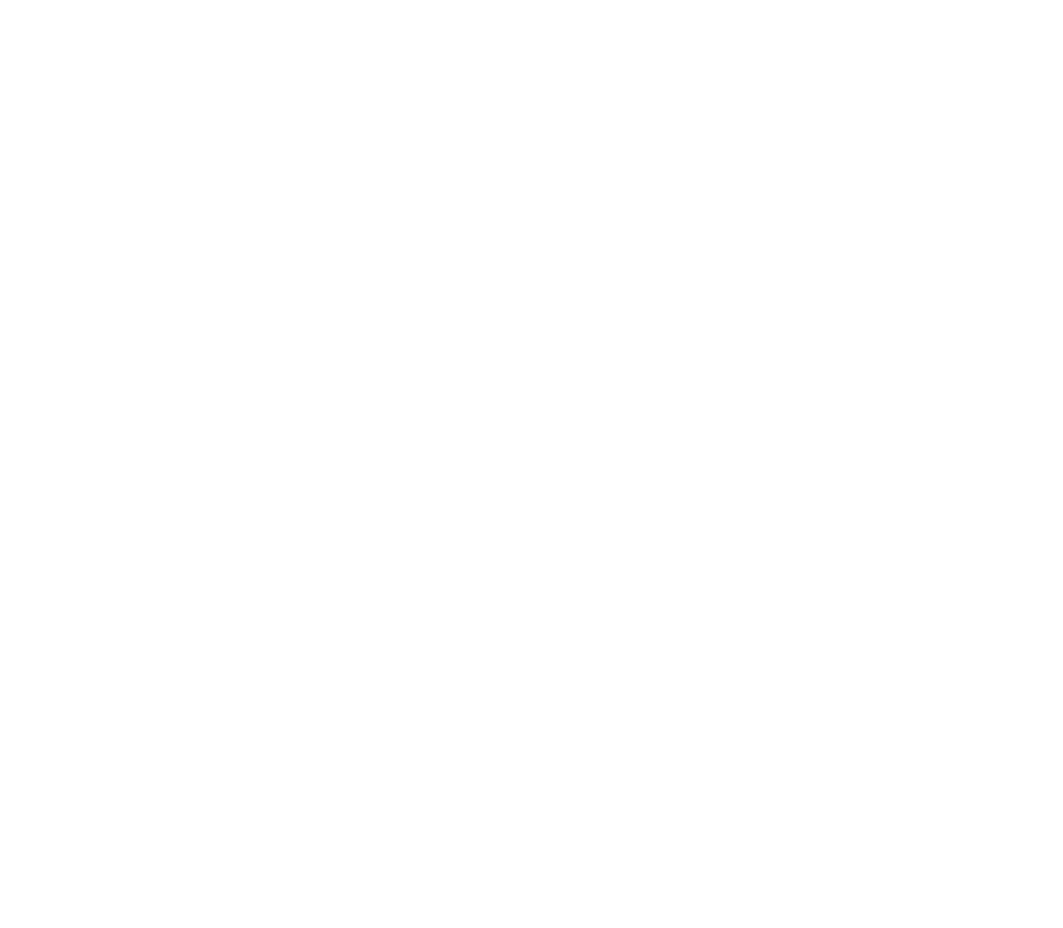
Figure 3. Heatmaps of significant changes in TIA and migraine groups between 2-weeks and 1-year. Participants are arrayed along the x-axes in no particular order. - A affected arm, - UA unaffected arm, - D dominant arm, - ND non-dominant arm. Blue cells represent significant lowering (improvement) in Task Score between 2 weeks and 1 year. Red cells represent significant increase (deterioration) in Task Score between 2 weeks and 1 year. Gray cells indicate missing values for those participants. Fractions improved and deteriorated are represented on the right-hand side of each axis for each